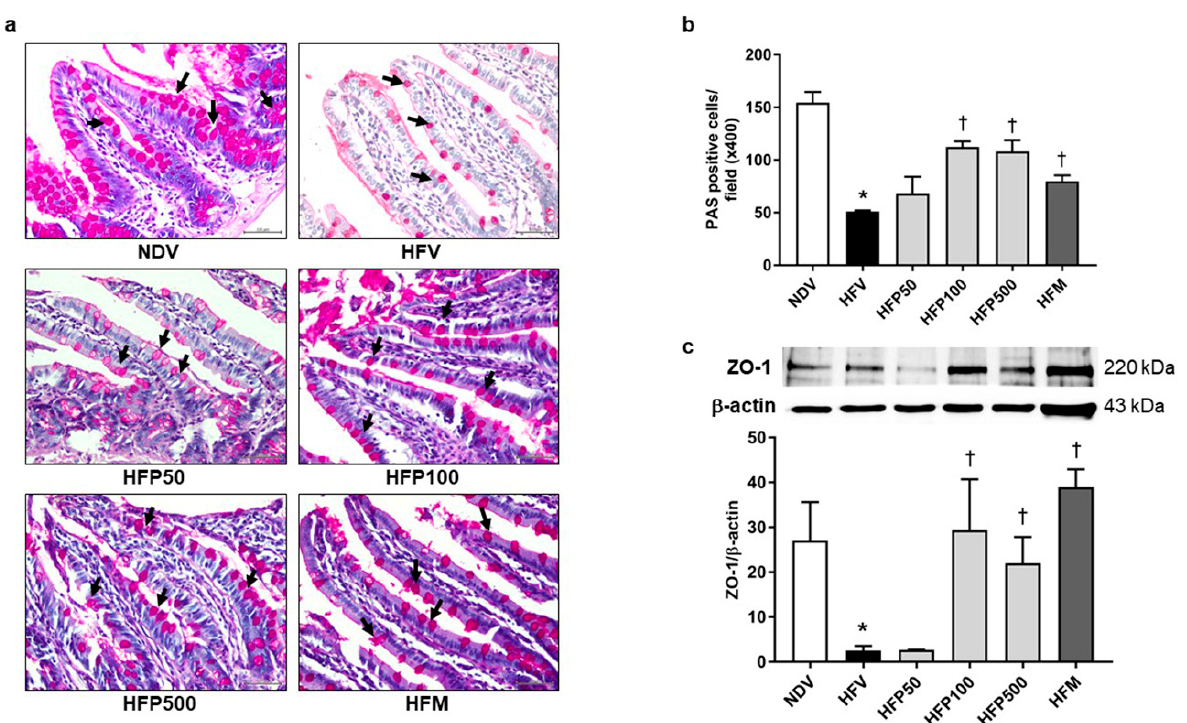
Figure 3. Effect of PSO on intestinal barrier integrity in obesity-induced insulin-resistant rats. ( a ) Representative image of PAS-positive goblet cells indicated by black arrows, ×400 magnification. ( b ) The percentage of goblet-positive cells was analyzed using light microscopy with a high-power field (×400 magnification) from at least five fields. ( c ) Expression of ZO-1 in the ileum. Data are presented as mean ± SEM, * p < 0.05 versus the NDV group; † p < 0.05 versus the HFV group. PSO = Perilla seed oil; PAS = Periodic Acid-Schiff; ZO-1 = Zonula occludens-1; NDV = Normal diet-fed rats treated with the vehicle; HFV = High fat diet-fed rats treated with vehicle.